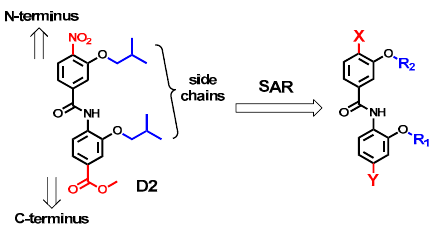
Figure 1. The structure of D2 and the structure-activity relationship study at the N / C-terminus (X and Y) and side chains (R 1 and R 2 ).